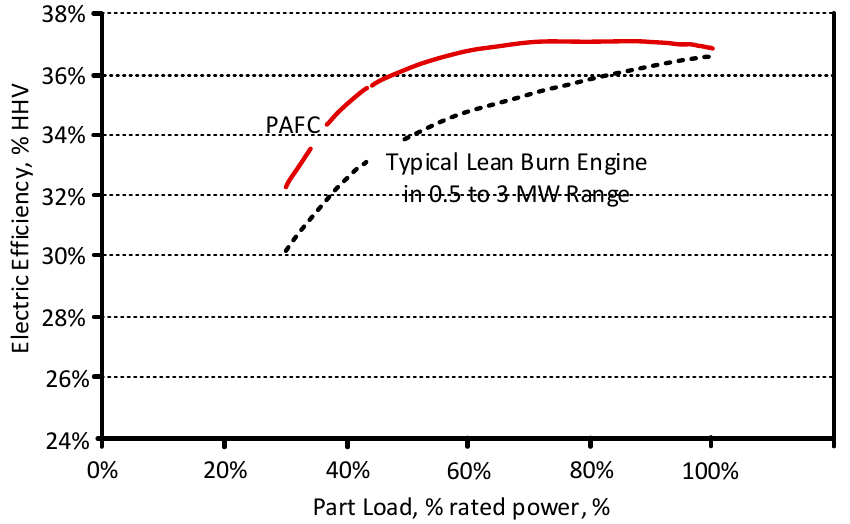
Figure 5 . PAFC performance at partial loads. Figure 5. PAFC performance at partial